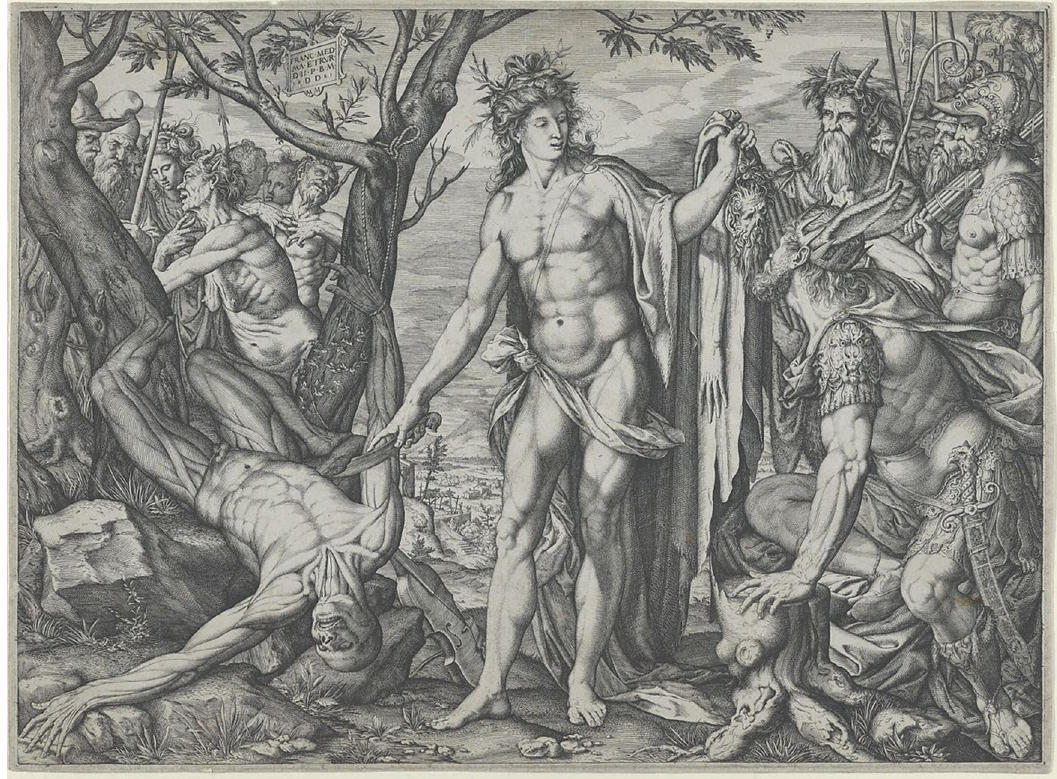
Figure 17: Melchior Meier, Apollo and Marsyas and the Judgment of Midas , 1581. Metropolitan Museum of Art, NYC. Public